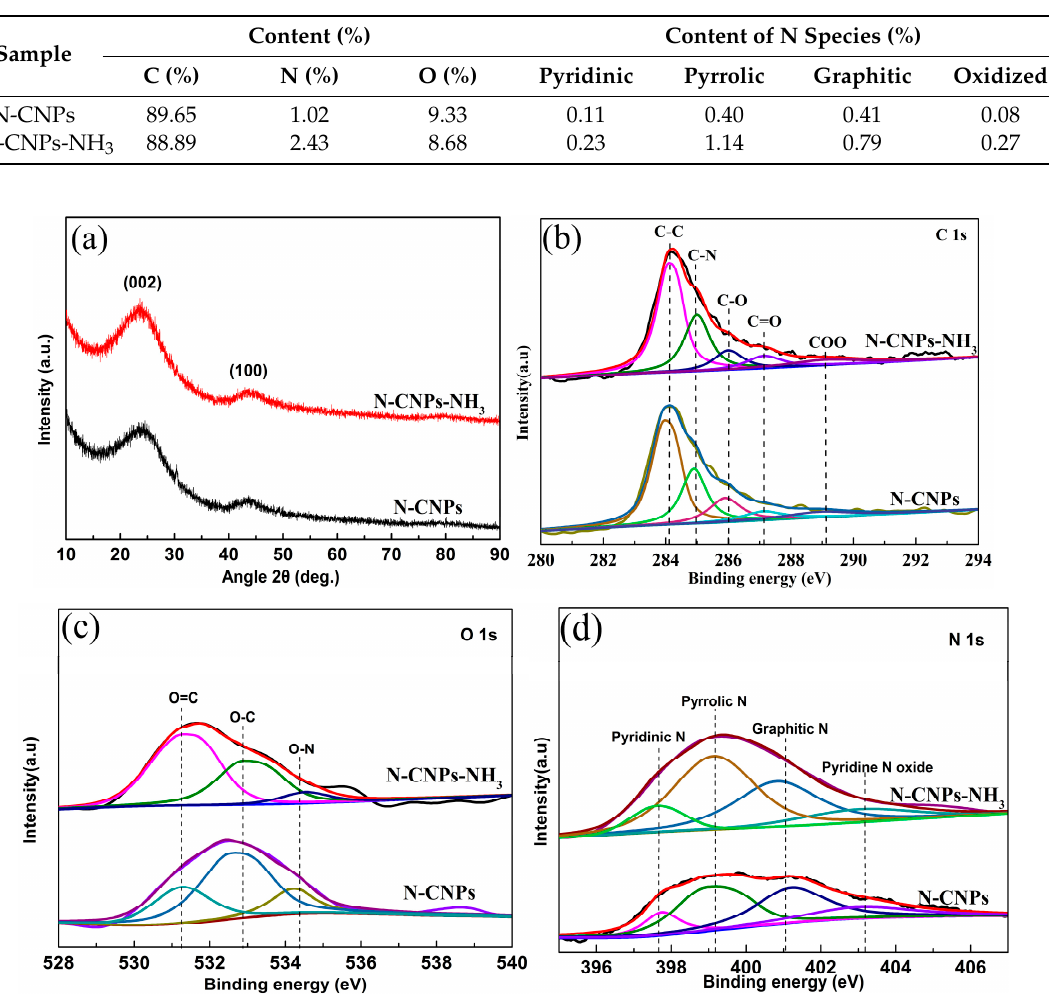
Figure 2. ( a ) XRD patterns of the N-CNPs and N-CNPs-NH 3 samples. High-resolution XPS spectra. ( b ) C 1s; ( c ) O 1s; and ( d ) N 1s bands of N-CNPs and N-CNPs-NH 3